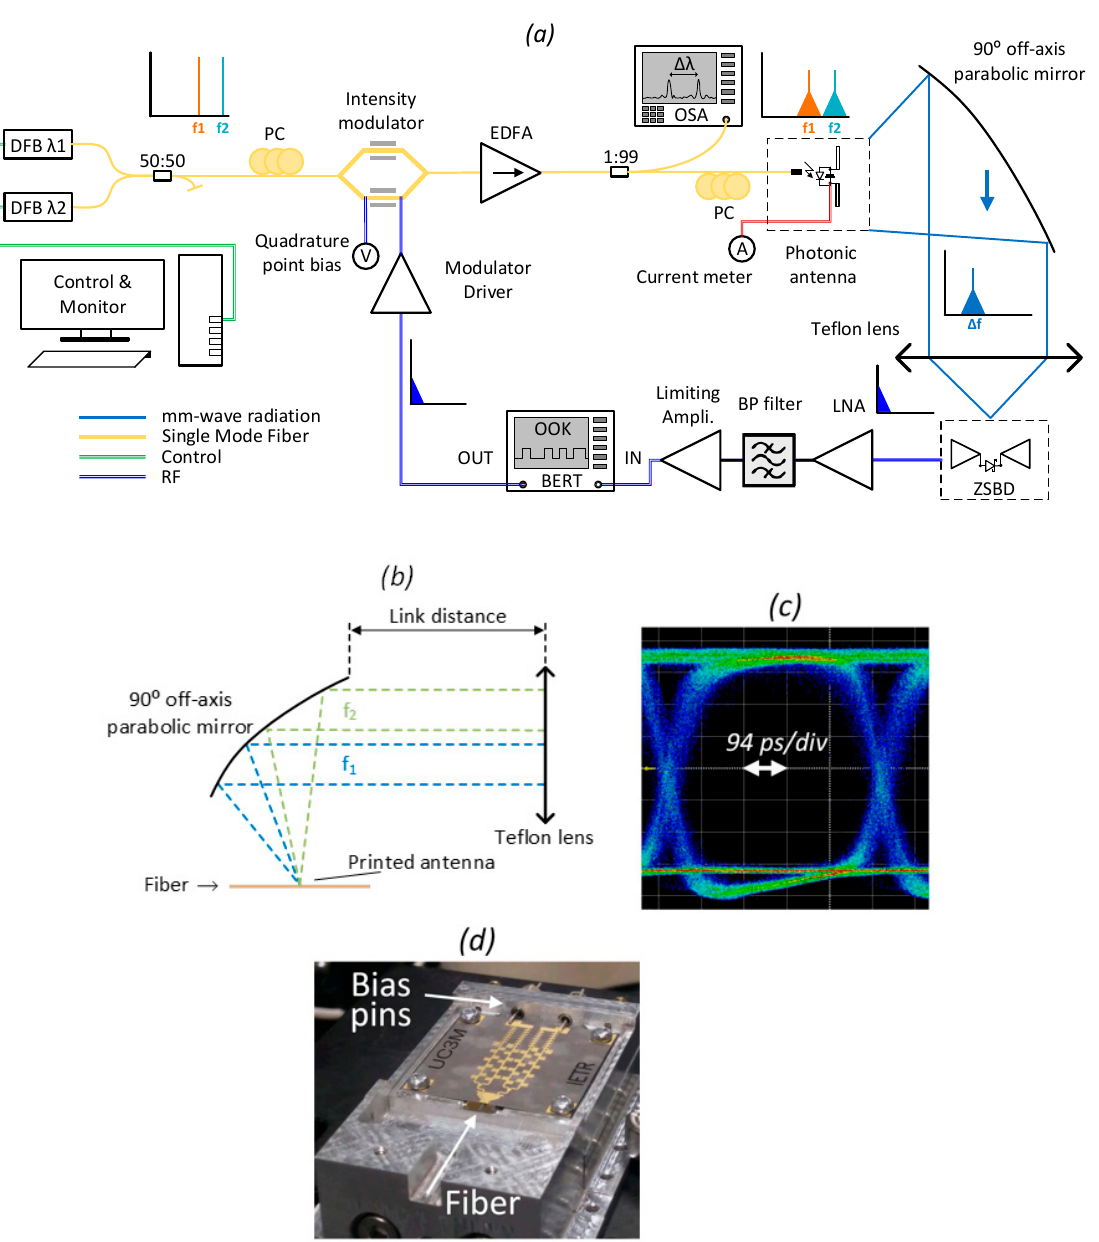
Figure 9. ( a ) Schematic of the set-up utilized for the wireless link (PC = polarization controller, BP = bandpass, LNA = low noise amplifier). ( b ) Simplified QO system, ( c ) eye diagram for the error-free transmission at 2.15 Gbps, and ( d ) photograph of the prototype. Table 1. Wireless link with one active PD: summary of main parameters.